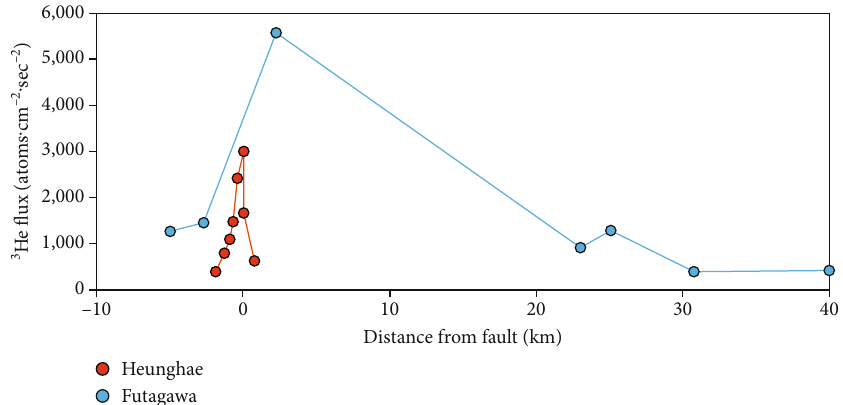
Figure 6: 3 He fl ux values displayed according to the distance from the Heunghae fault in the Pohang region (this study) and the Futagawa fault in the Kumamoto region, Japan [6]. The assumptions about the calculations are described in section 4.5.